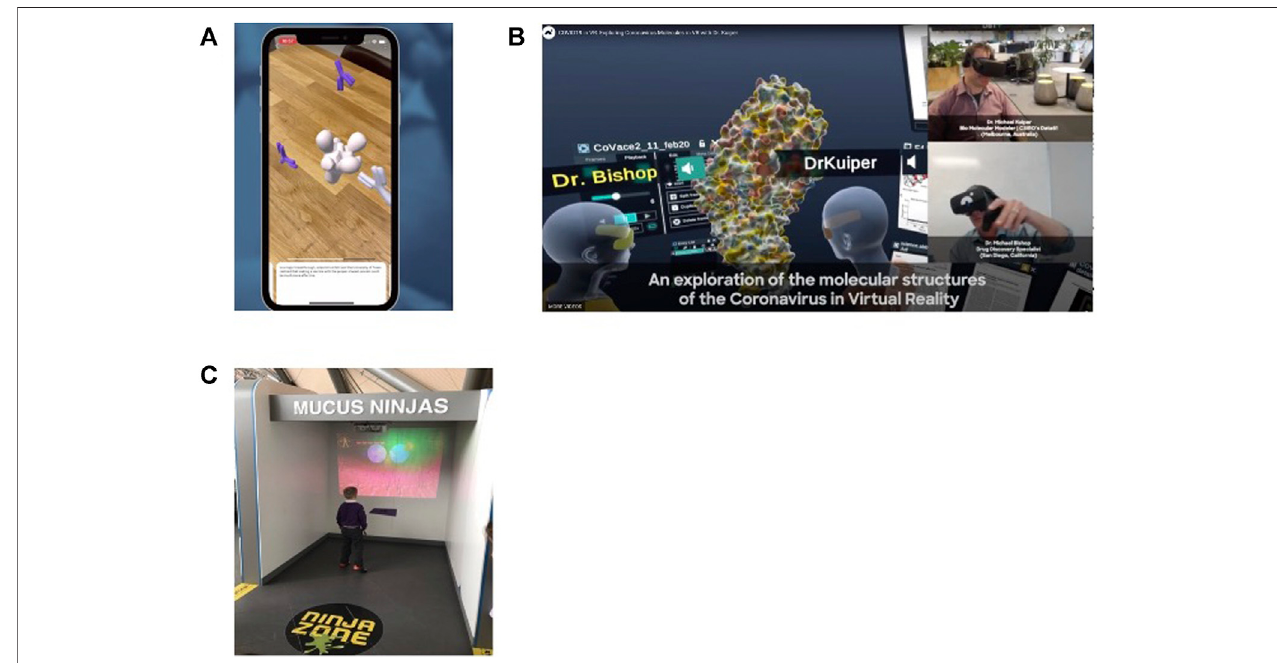
FIGURE 12 | Extended Reality examples (A) Augmented reality for mRNA exploration (USA Today, 2021) (B) Virtual Reality for co-exploring of Covid-19 (Kulper, 2020) (C) Whole body interactive game at Glasgow Science Centre, United